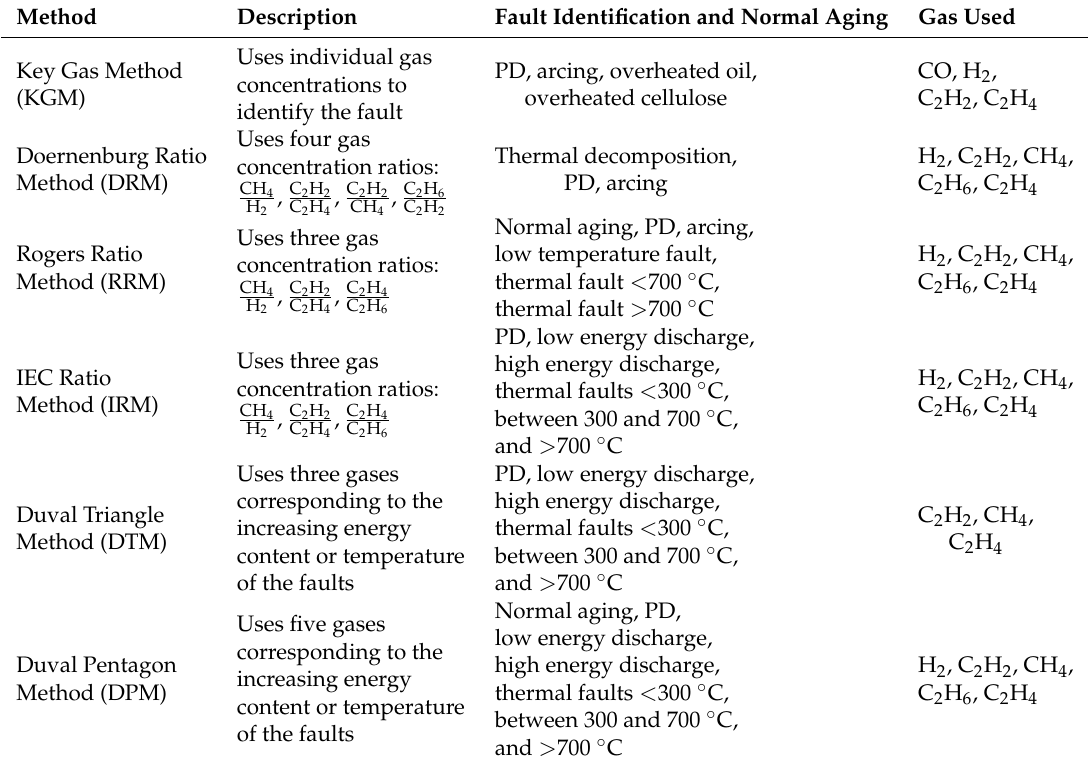
Table 3. Comparison between fault identification methods